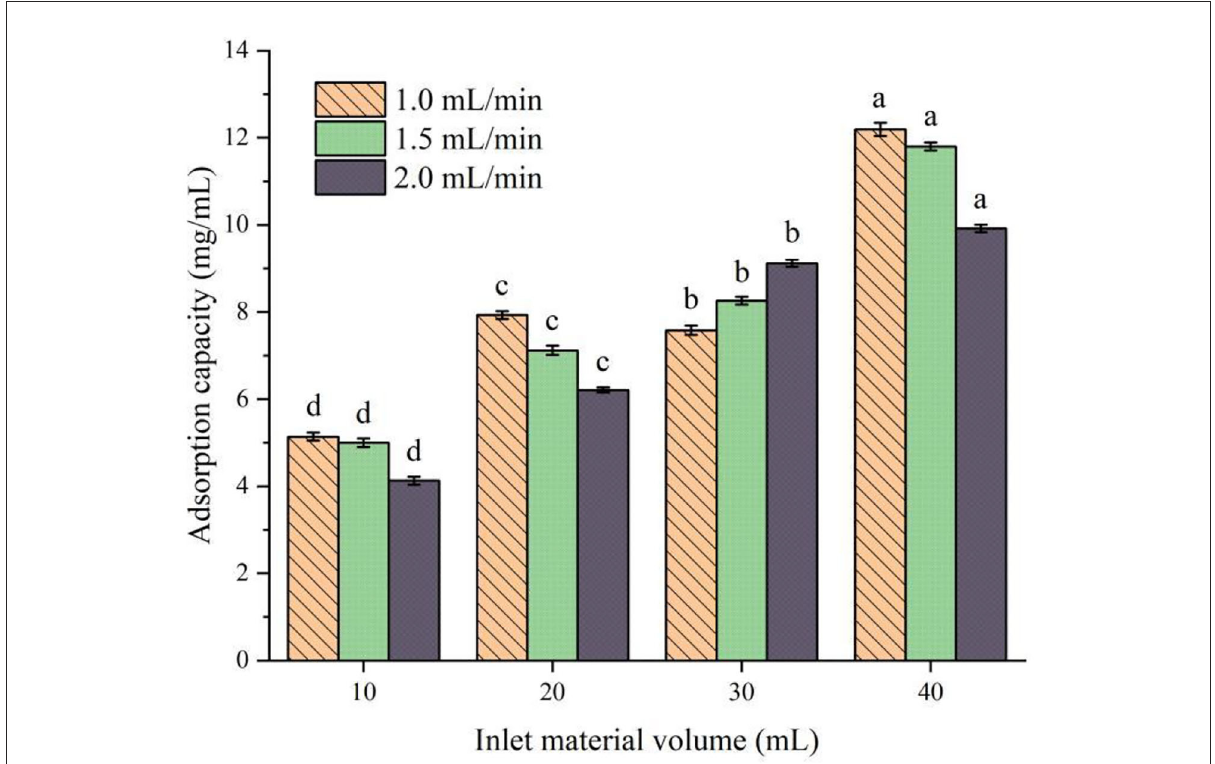
FIGURE4 Effects of different flow rates and feed amounts on the adsorption of protein peptides in PSKB. There is a significant difference between different small letters ( P < 0.05).